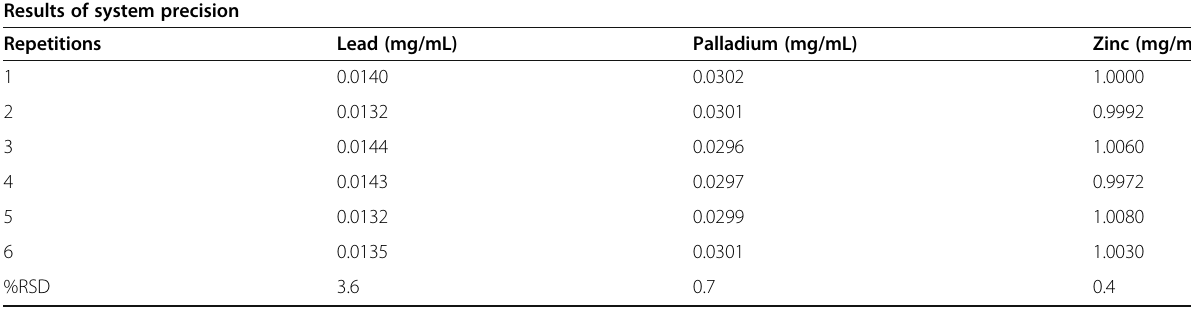
Table 9 System precision results of Lead, Palladium, and Zinc